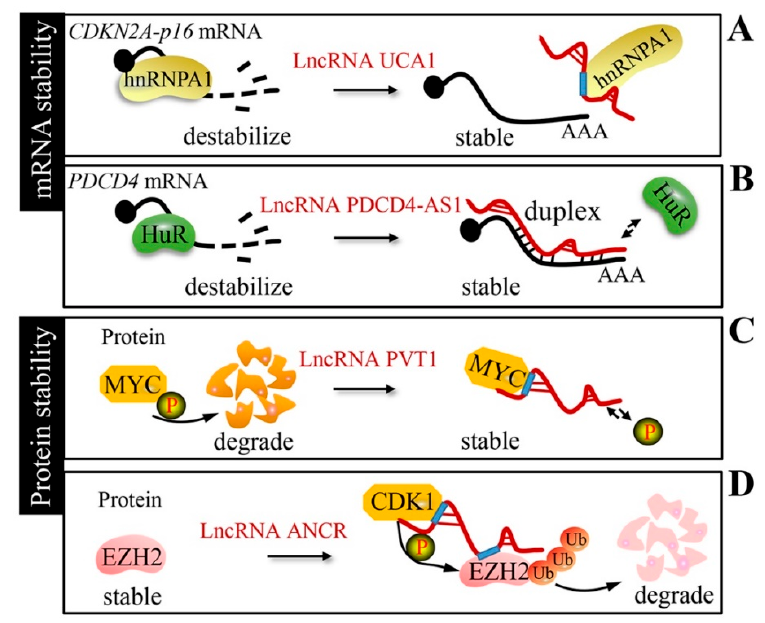
Figure 4. Stability mechanism. ( A ) LncRNA UCA1 stabilizes CDKN2A-p16 mRNA by sequestering heterogeneous nuclear ribonucleoprotein A1 (hnRNPA1). ( B ) LncRNA PDCD4-AS1 forms an RNA duplex with PDCD4 mRNA to expel ELAV-like RNA binding protein 1 (HuR). ( C ) LncRNA plasmacytoma variant translocation 1 (PVT1) protects the MYC protein from phosphorylation-mediated degradation. ( D ) LncRNA ANCR interacts with EZH2 and promotes the CDK1-mediated phosphorylation and degradation of EZH2.